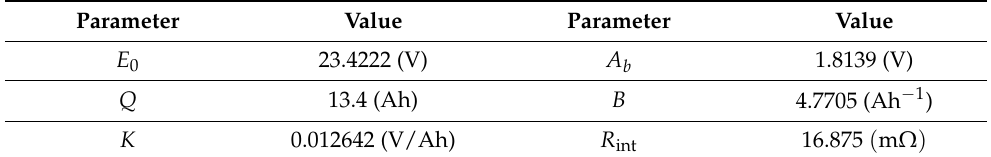
Table 2. Parameters of the BAT model.